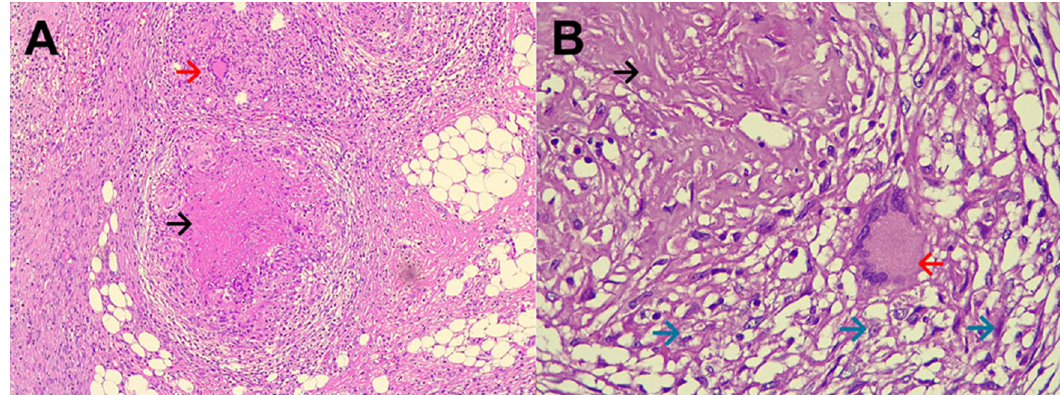
Figure 5. A: Electronic microphotography (x10) showing epiploon with chronic granulomatous inflammation, caseous necrosis (black arrow) and Langhans multinucleated giant cells (red arrow). B: Electronic micropho- tography (x40) showing Langhans multinucleated giant cells (red arrow); caseous necrosis (black arrow); and epithelioid histocytes (green arrows). Hematoxylin and Eosin stains. Periodic acid-Schiff and Ziehl-Neelsen stains were